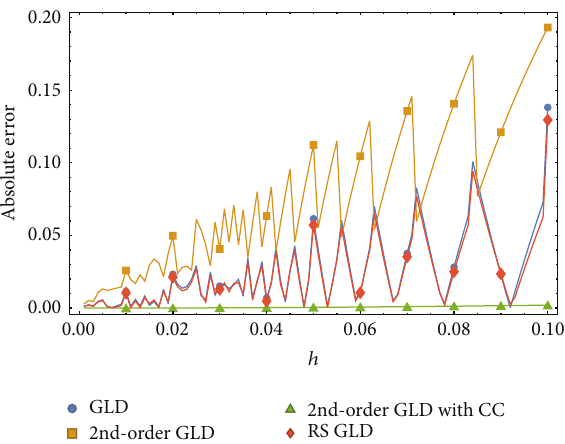
Figure 11: Absolute error for increasing 𝑁 for four different methods.